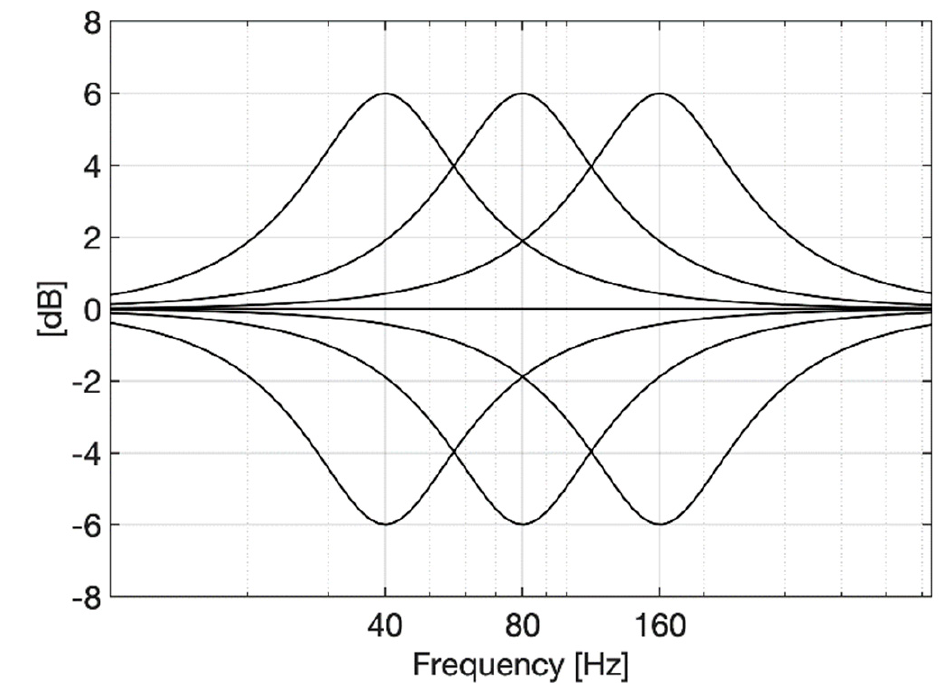
Figure 1. Frequency responses of the equalizations.